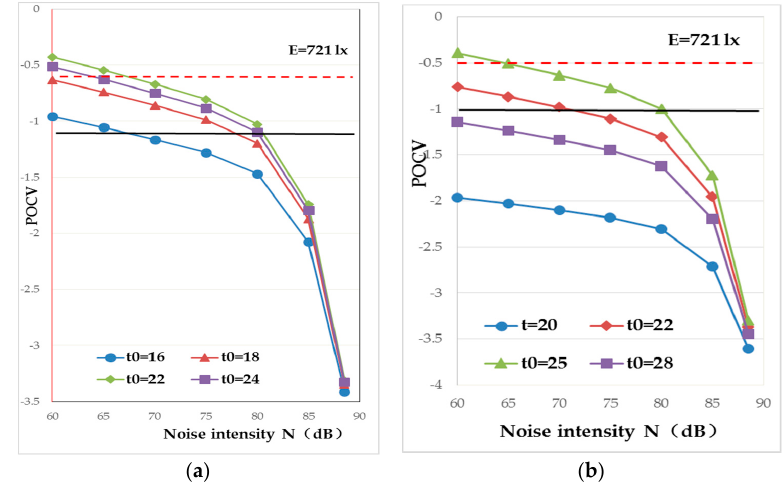
Figure 14. Corresponding POCV value of temperature and illumination at different noises intensity: ( a ) Winter; ( b ) Summer.